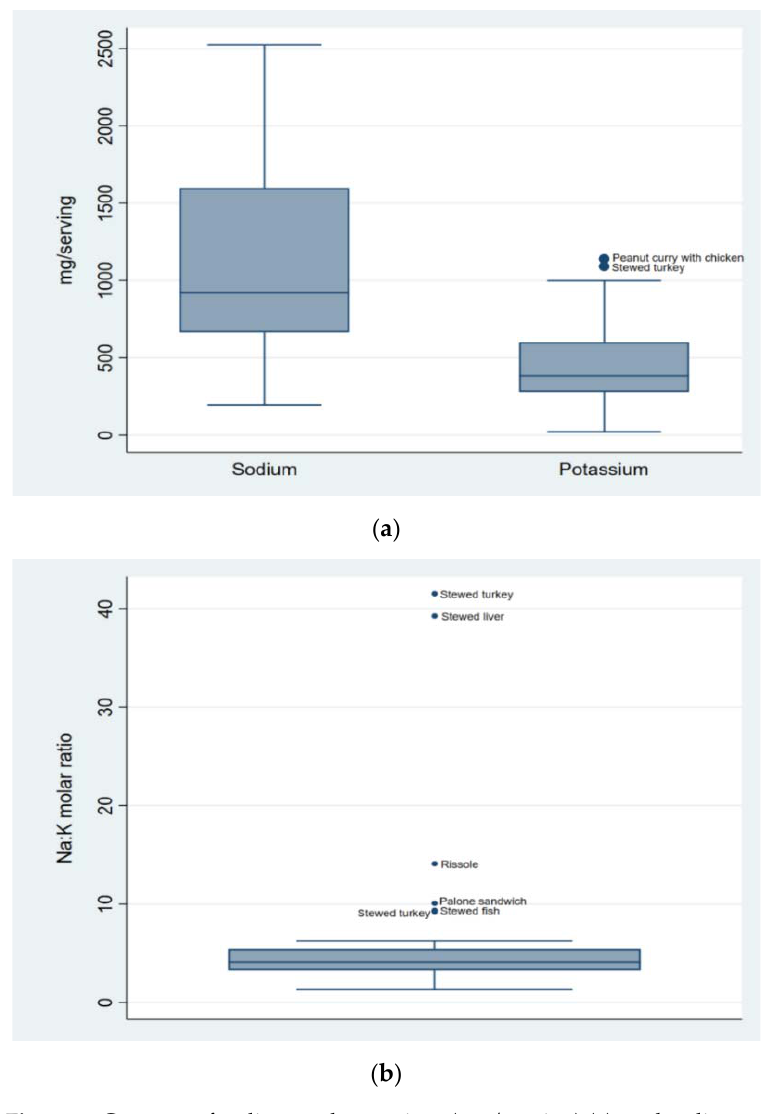
Figure 2. Contents of sodium and potassium (mg/serving) ( a ), and sodium to potassium molar ratio ( b ) of all food samples collected ( n = 56). Palone, known as Polony in South Africa, is a sausage derived from mortadella. It can be made of beef, chicken, turkey, a combination or soy protein, plus condiments and fat. It is usually served cold, in slices. Rissole is a deep-fried pastry filled with a sauce of